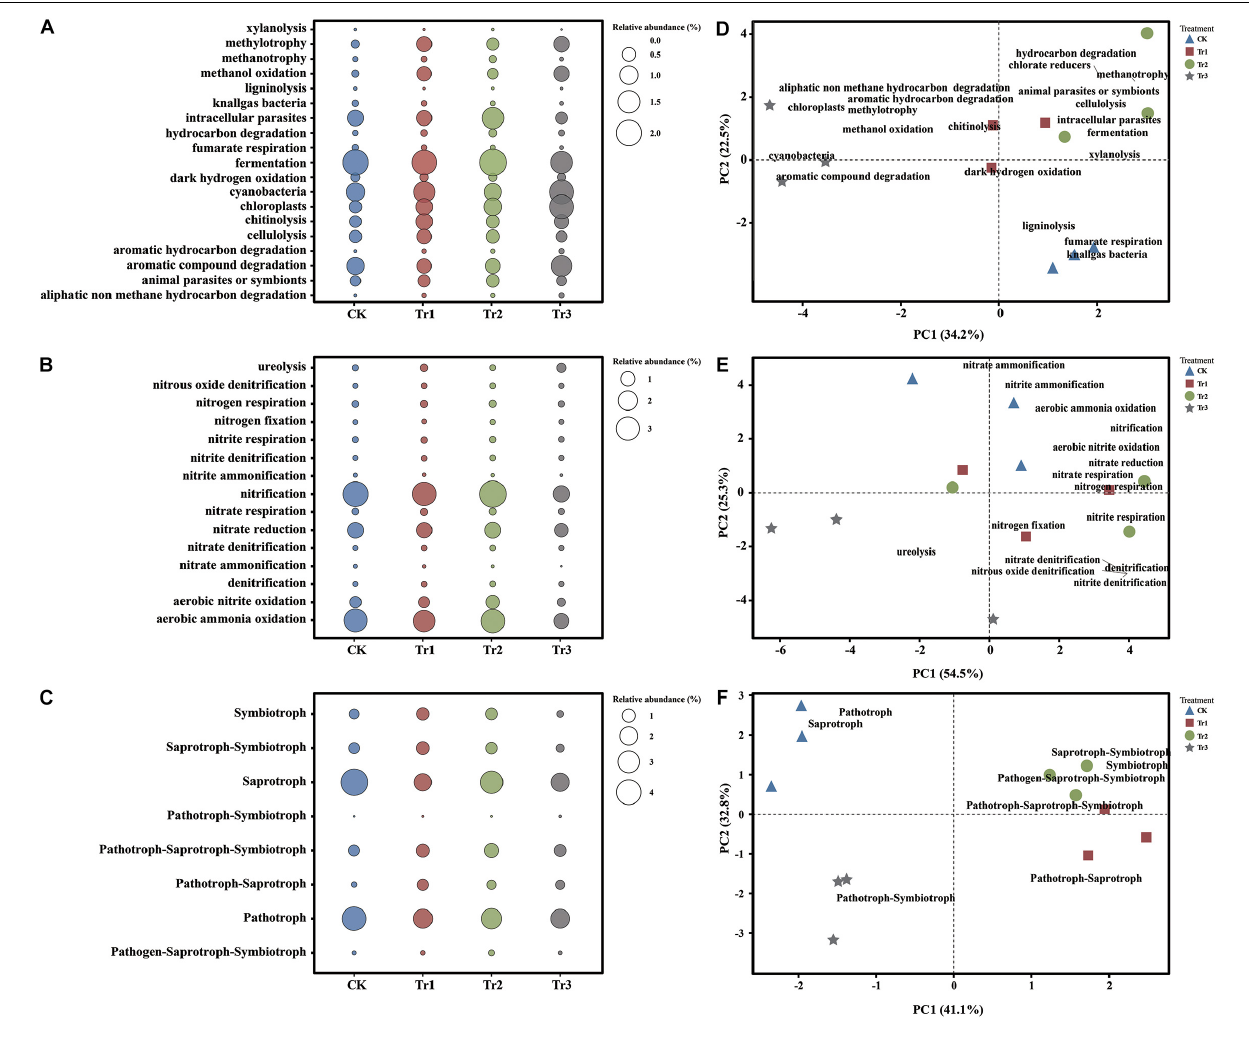
related to trophic patterns indicated a clear separation among were mainly clustered in the control ( Figure 4F